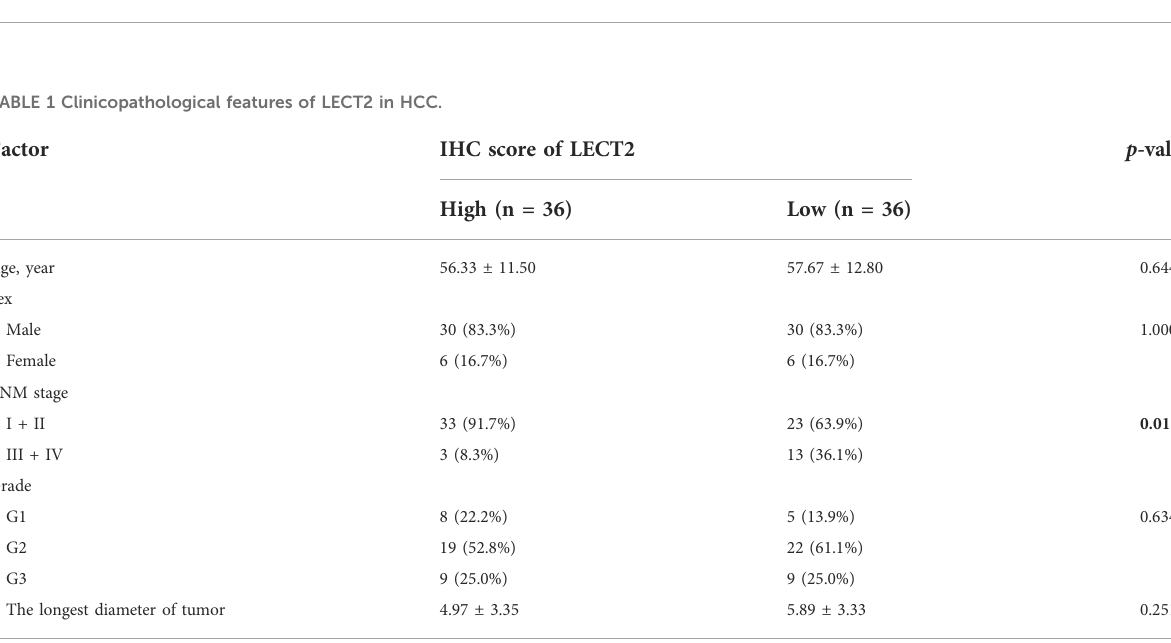
FIGURE 4 Expression levels and prognostic analysis of LECT2. (A – B) Representative IHC maps of LECT2 expression in HCC tissues and adjacent normal tissues (C) The expression levels of LECT2 in 72 cases of HCC and normal tissues, blue represents HCC tissue, yellow represents adjacent normal tissues (D) The prognostic analysis of LECT2 in 72 cases of HCC.